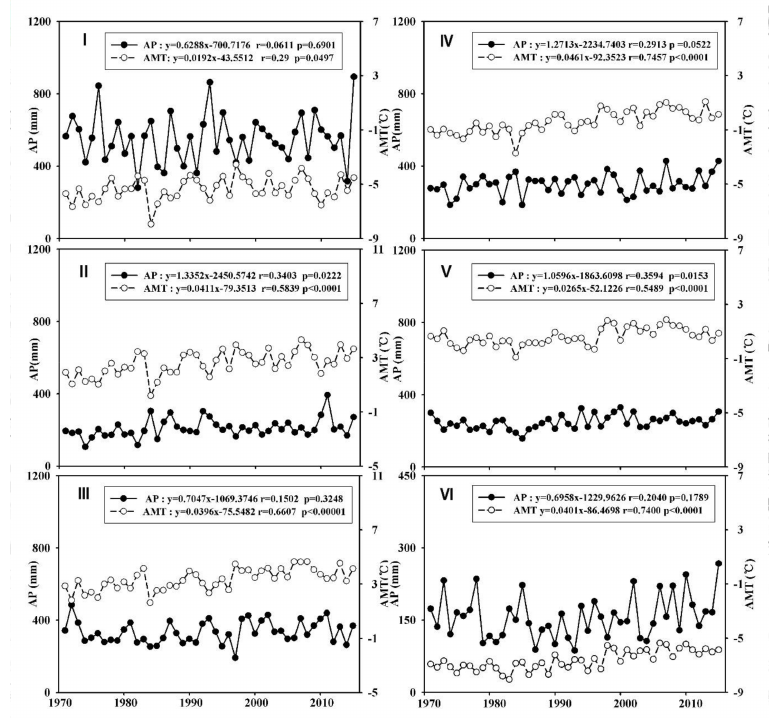
Figure 4. Interannual variations in annual precipitation (AP, mm) and annual mean temperature (AMT, ◦ C) at each region from 1971 to